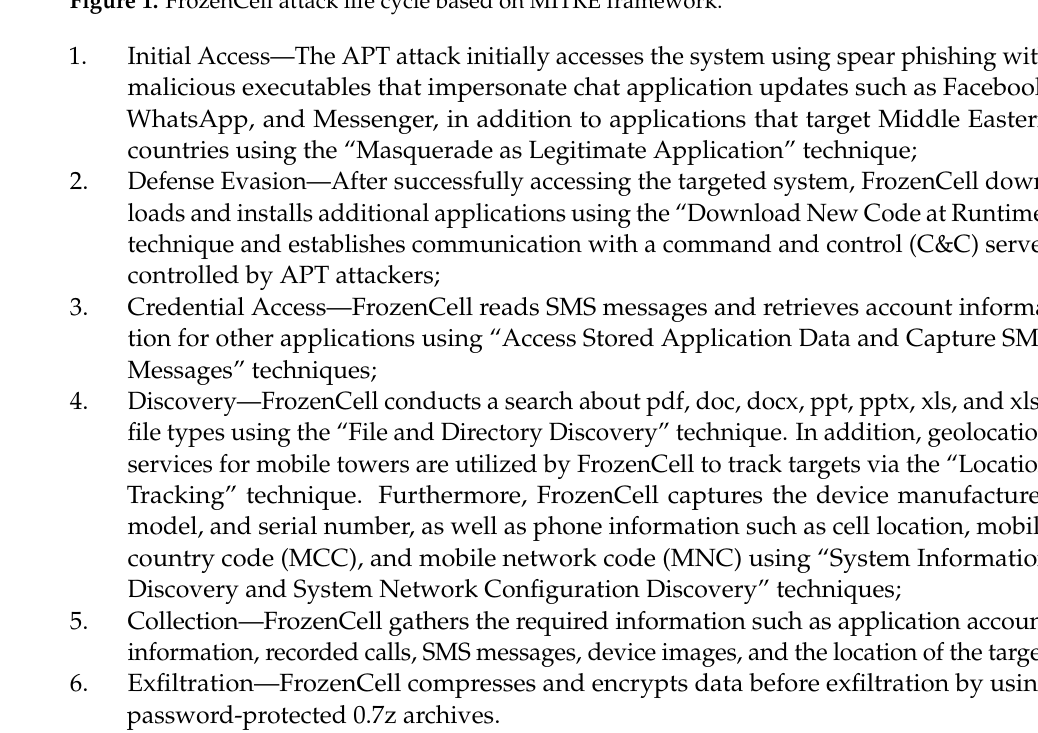
Figure 1. FrozenCell attack life cycle based on MITRE framework.